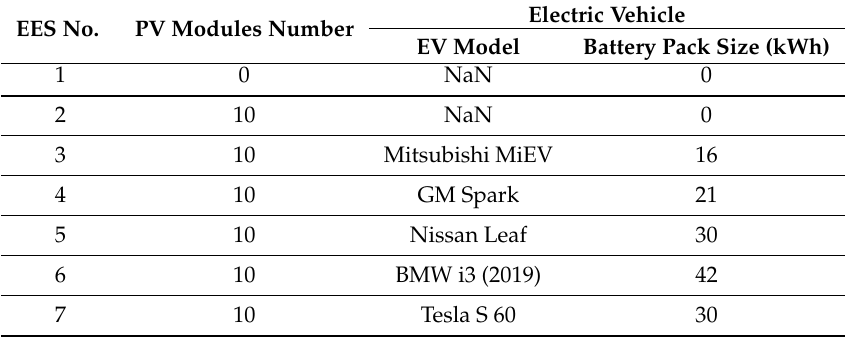
Table 7. Different configurations of EES for comparing the cost quantities. EES